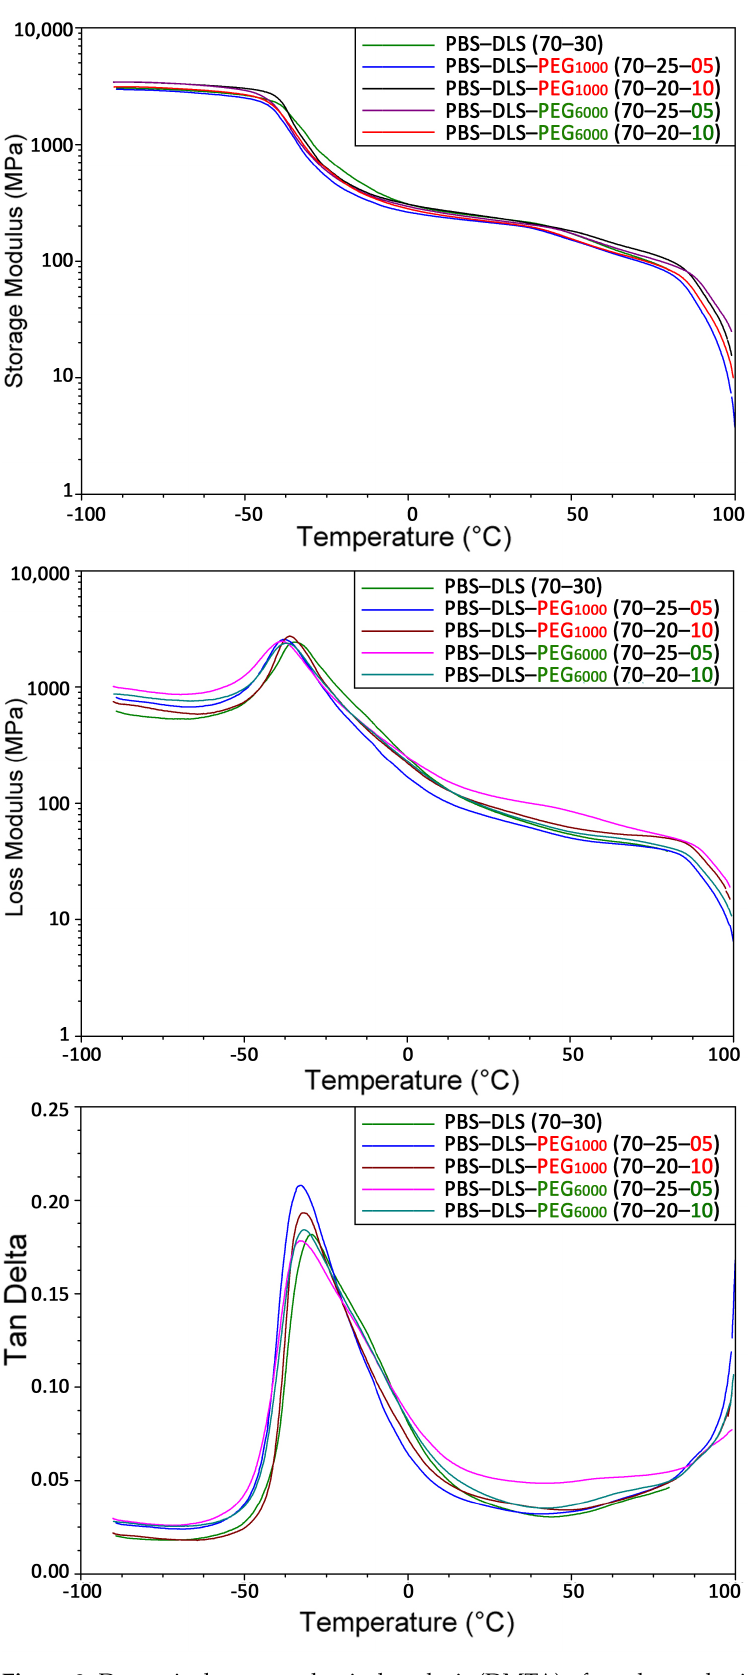
Figure 8. Dynamic thermomechanical analysis (DMTA) of newly synthesized copolymers of PBS- DLS-PEG: storage modulus, G’ (top), loss modulus, G” (middle), and tangent of delta, tan δ